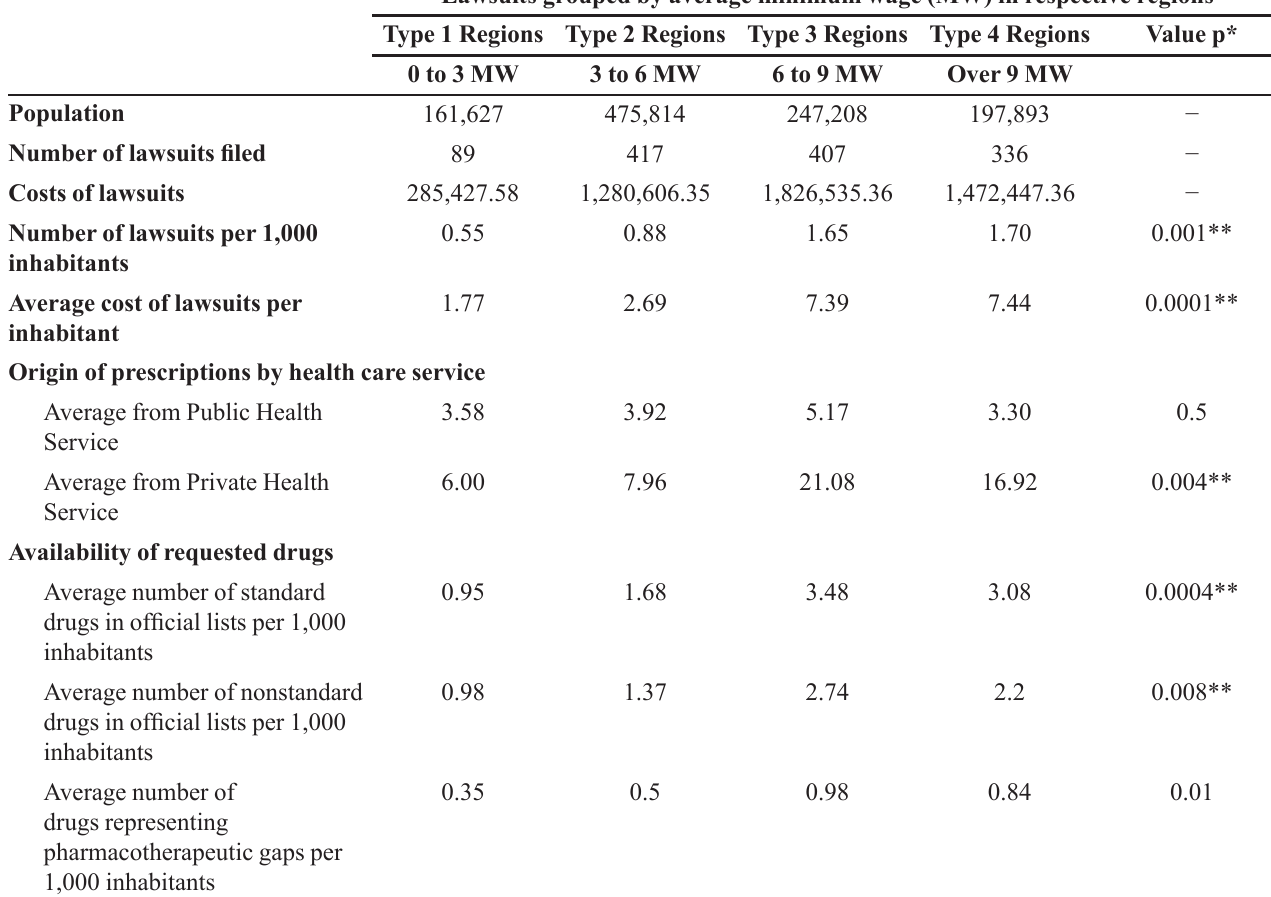
TABLE I - Characteristics of judicial demands by intra-city region with different incomes Lawsuits grouped by average minimum wage (MW) in respective